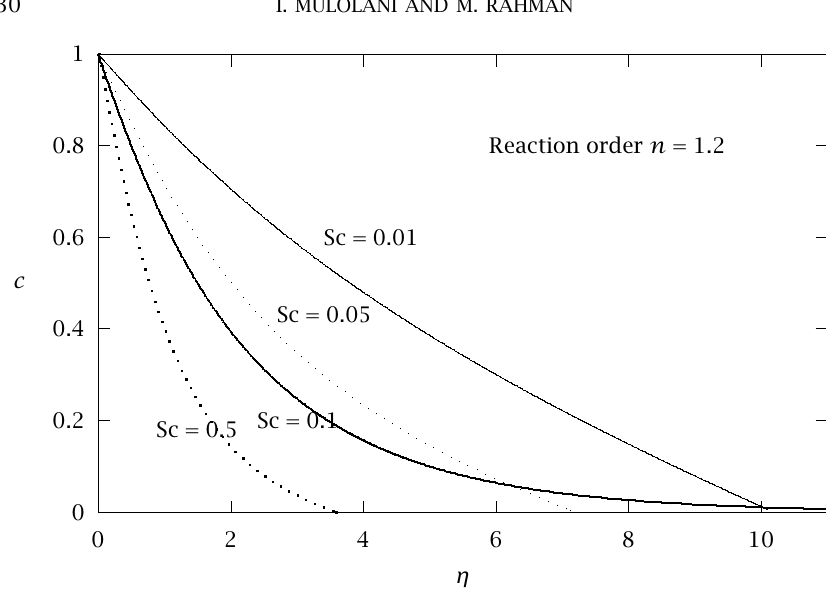
Figure 5.6 . Concentration profiles for n = 1 . 2.